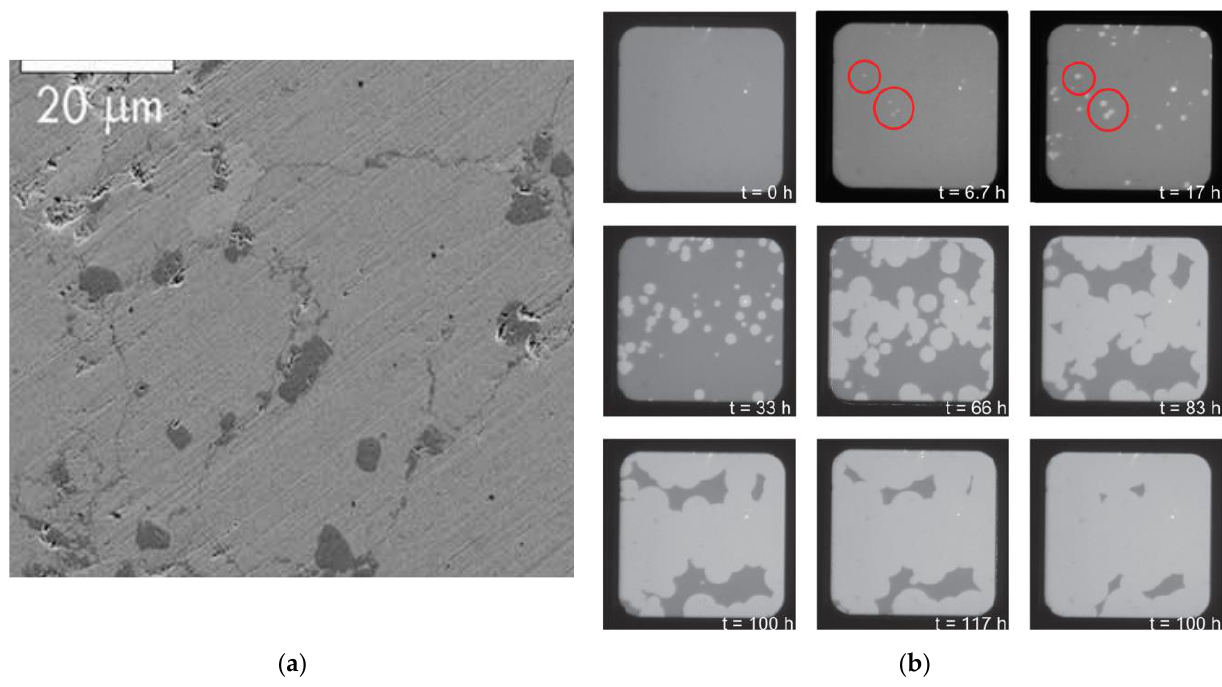
Figure 6. ( a ) SEM images at 1 kV at different magnifications of the MgH 2 , where nucleation of MgH 2 phase (the dark particles) occurs at grain boundaries [63]; ( b ) Visual images of the Ti – Mg – Ti – Pd multilayer sample hydrogenation at several times during a full hydrogenation cycle under hydrogen pressure of 70 Pa and temperature of 90 °C. The MgH 2 nuclei are indicated by the red circles [79].